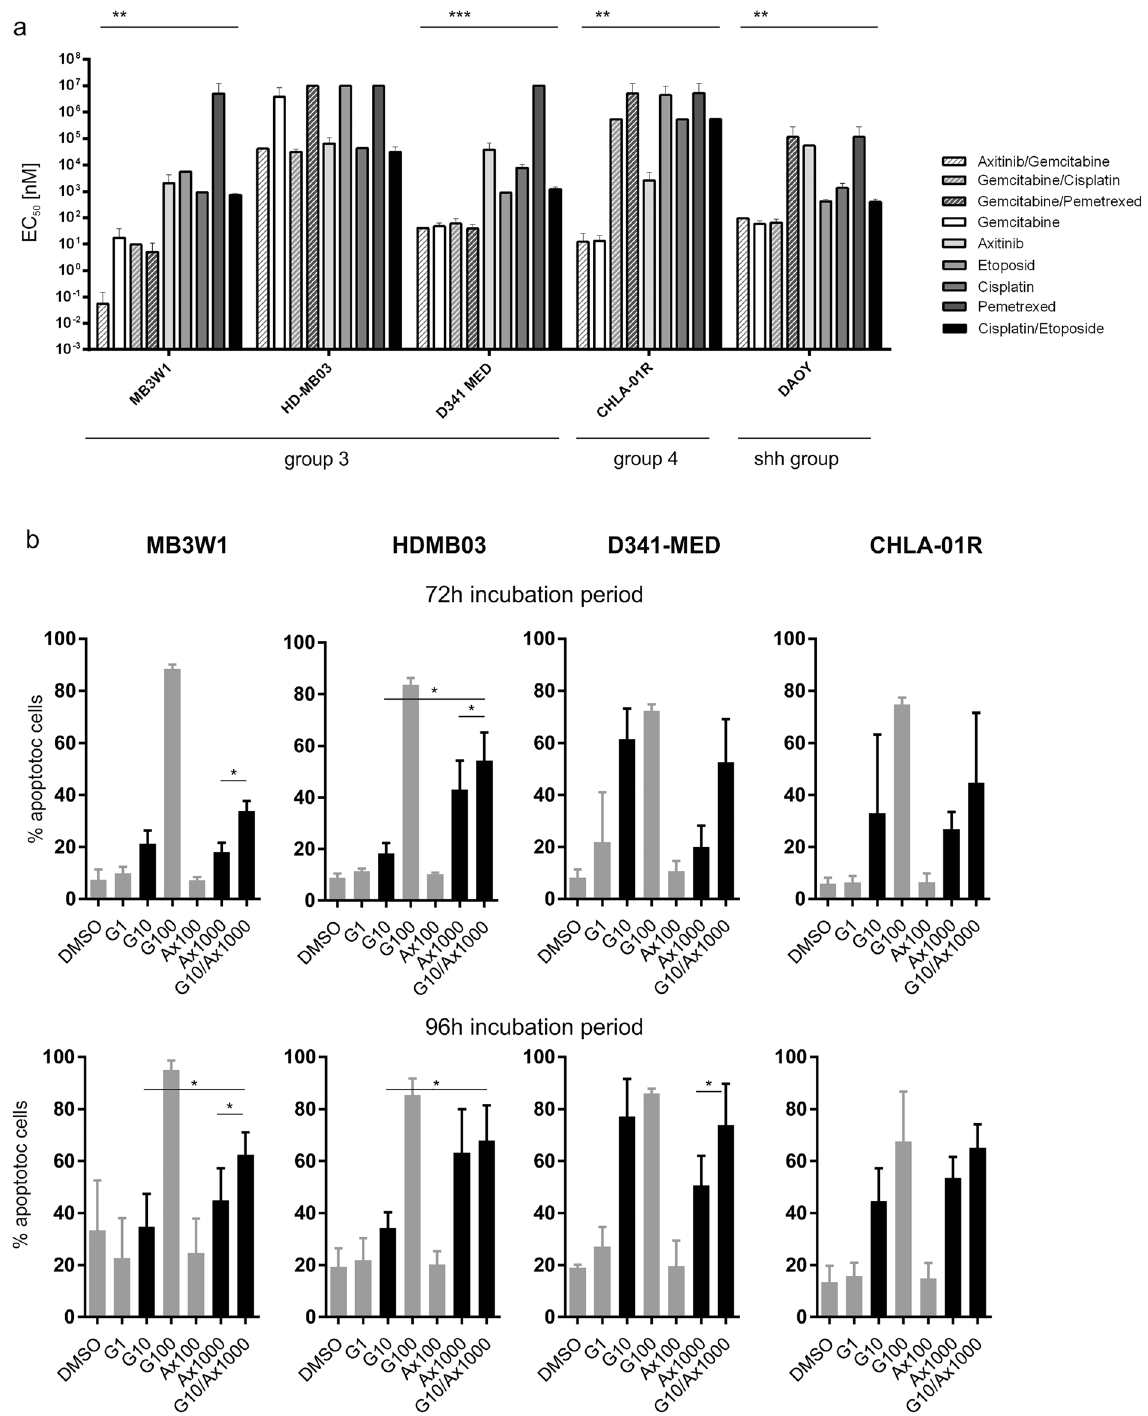
Figure 3. ( a ) EC 50 -values of group 3, group 4 and SHH tumor cell lines treated with different cytostatic drugs (Mean ± SD; representative data from five independent experiments) Gemcitabine/axitinib vs. vehicle: MB3W1: **, p = .0079, D341MED: ***, p = .0009, CHLA-01R: **, p = .0079, DAOY: **, p = .005. All experiments involving ‘etoposide’ were done using its phosphate. ( b ) Medulloblastoma cell lines grown in FCS-free conditions and tested for apoptosis 72 h and 96 h respectively using ApotrackerGreen. Cells were exposed to the respective drugs with G1 meaning Gemcitabine 1 nM, other labelling accordingly. Black bars indicate the relevant dosages for mono- and combination therapy. Only this monotherapy was compared to combination therapy (paired t-test; only significant results are shown with * p < .05).Grey bars indicate additional concentrations tested in monotherapy